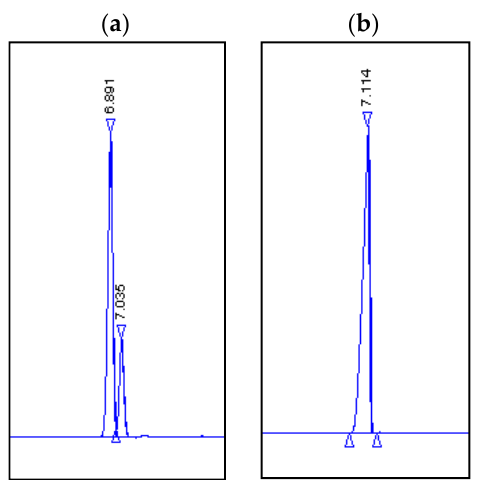
Figure 4. Chromatograms. ( a ) Products obtained by biotransformation using carrots: R f = 6.891, (1 R ,2 R ,4 R )-dihydrocarveol ( 4 ) and (1 R ,2 S ,4 R )-neodihydrocarveol ( 5 ); unreacted substrate: R f = 7.035, (1 R , 4 R )-(+)-dihydrocarvone ( 2 ). ( b ) Standard: R f = 7.114 (1 R , 4 R )-(+)-dihydrocarvone ( 2 ).